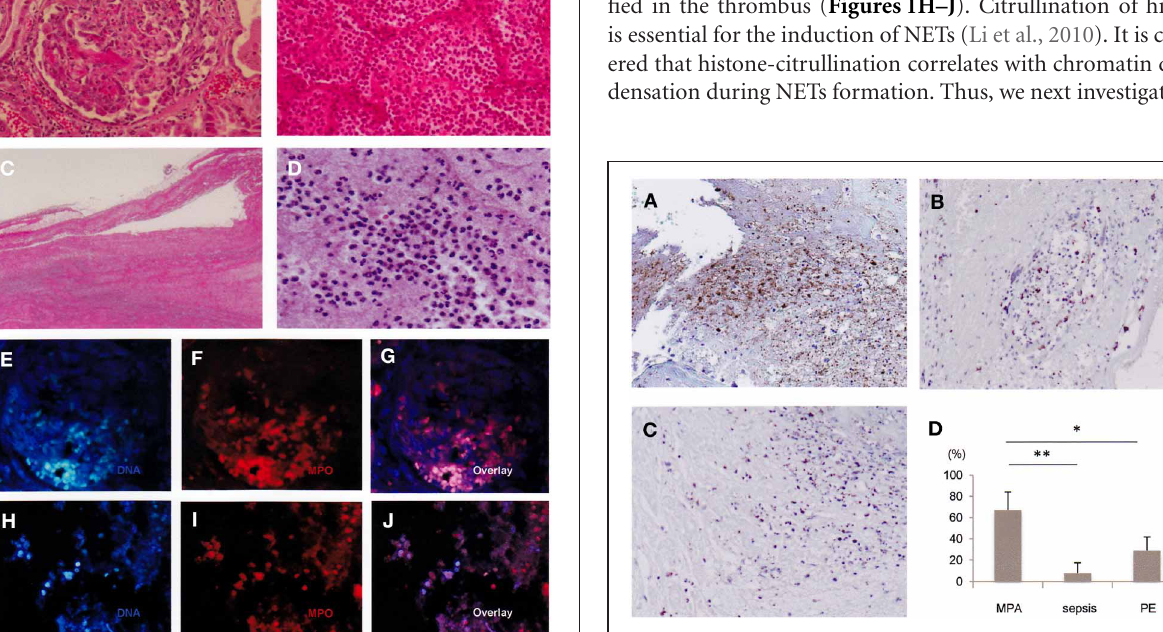
FIGURE 1 | Autopsy findings. (A) Crescentic necrotizing glomerulonephritis. (B) Alveolar hemorrhage with neutrophil infiltration. (C, D) DVT: neutrophils were abundant in the thrombus. (E–G) NETs in the glomerulus. Blue: DNA stained by DAPI. Red: MPO. NETs were present in the crescent. (H–J) NETs in the thrombus. The detection of NETs was performed similar to the renal specimens. Original magnification: × 40 (C) , × 200 (B) , × 400 (A, D, E–J) .